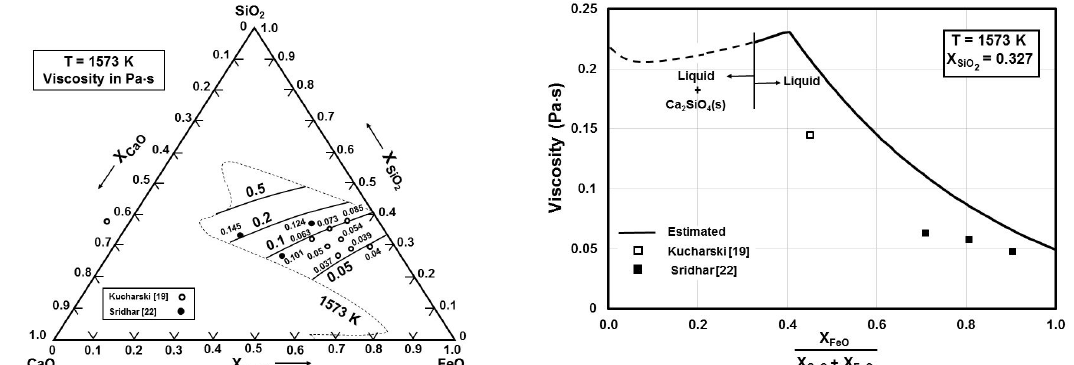
Figure 7. Calculated and experimental (19,22) viscosities in the SiO